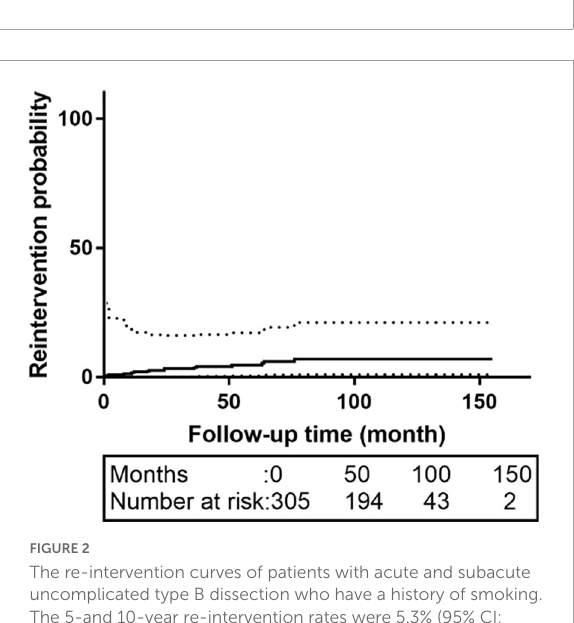
FIGURE1 The K-M survival curves of patients with acute and subacute uncomplicated type B dissection who have a history of smoking. The 5-and 10-year survival rates were 95.1% (95% CI: 92.3–98.1%) and 73.1% (95% CI: 60.7–87.9%), respectively. CI, confidence interval.